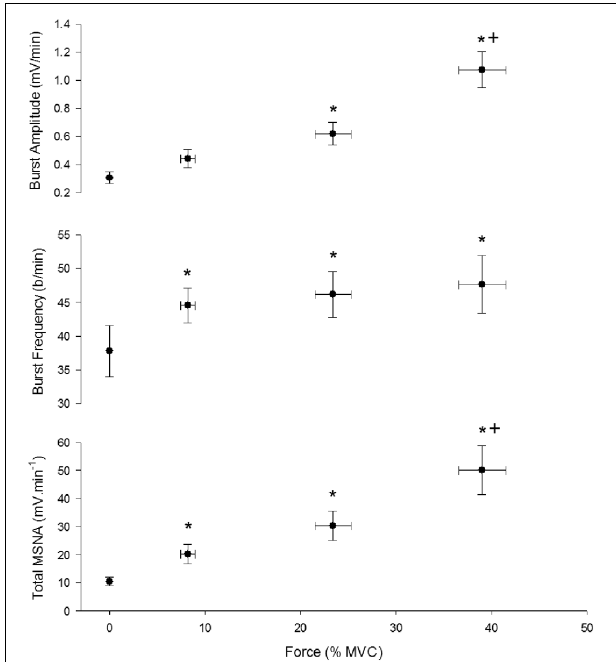
FIGURE 3 | Effect of contraction intensity on total MSNA, MSNA burst frequency, and MSNA burst amplitude during the first minute of contraction under control conditions. There was a significant main effect of intensity on total MSNA, burst frequency and burst amplitude. Asterisk ( ∗ ) indicates significantly different ( P < 0 . 05) from the resting responses. Cross ( + ) indicates significantly different ( P < 0 . 05) from 10 to 30% MVC responses at the specified time. These contrasts were based on post-hoc , two-tailed pairwise